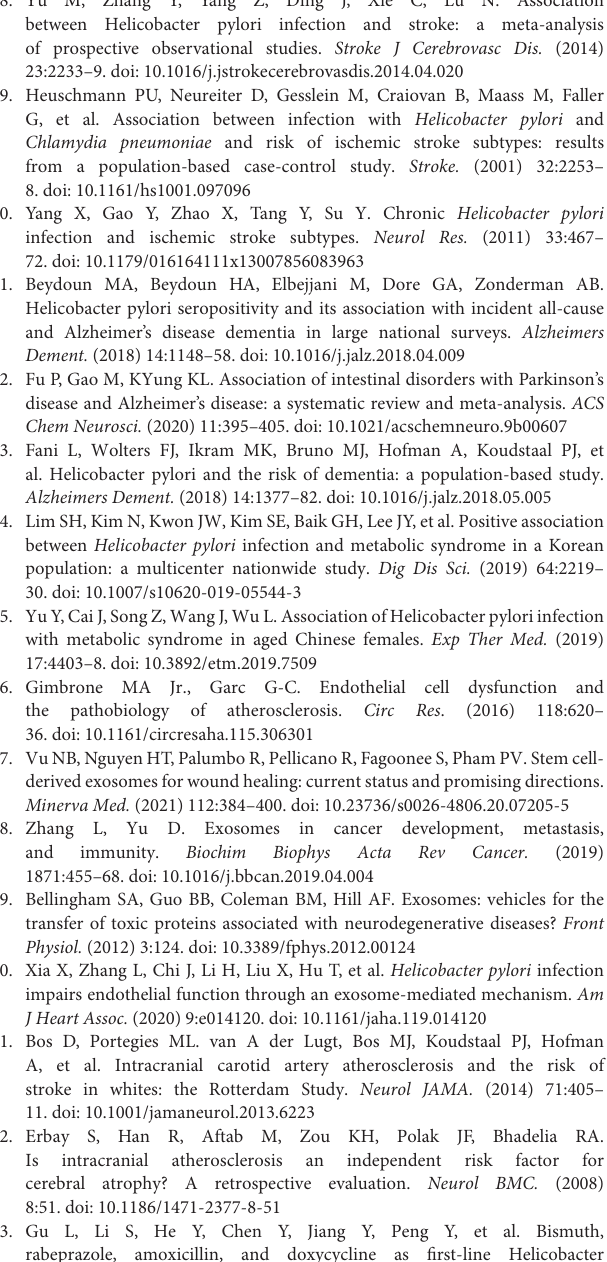
Supplementary Table 1 | Baseline characteristics for subjects with and without H. pylori Infection. Supplementary Figure 1 | Gender difference of H. pylori